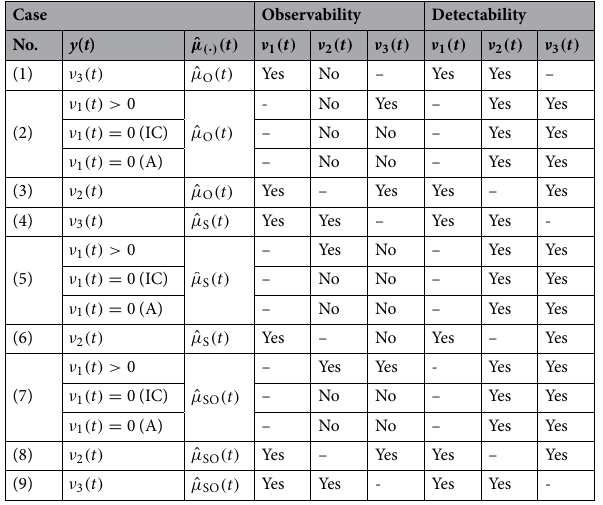
Table 3. Results of analysis based on indistinguishable dynamics without the